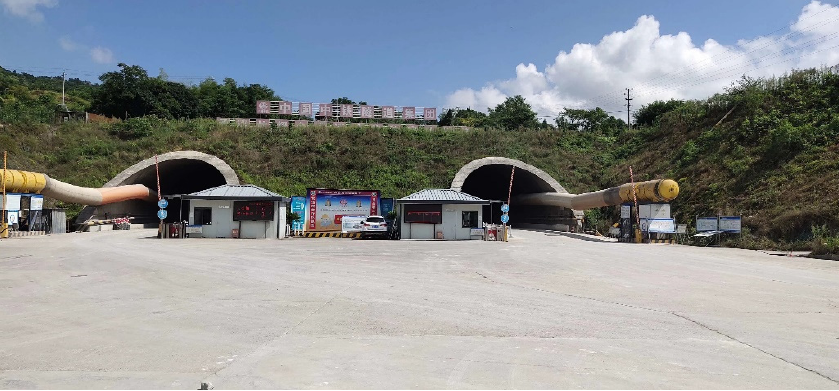
Figure 1. Panoramic view of tunnel exit.